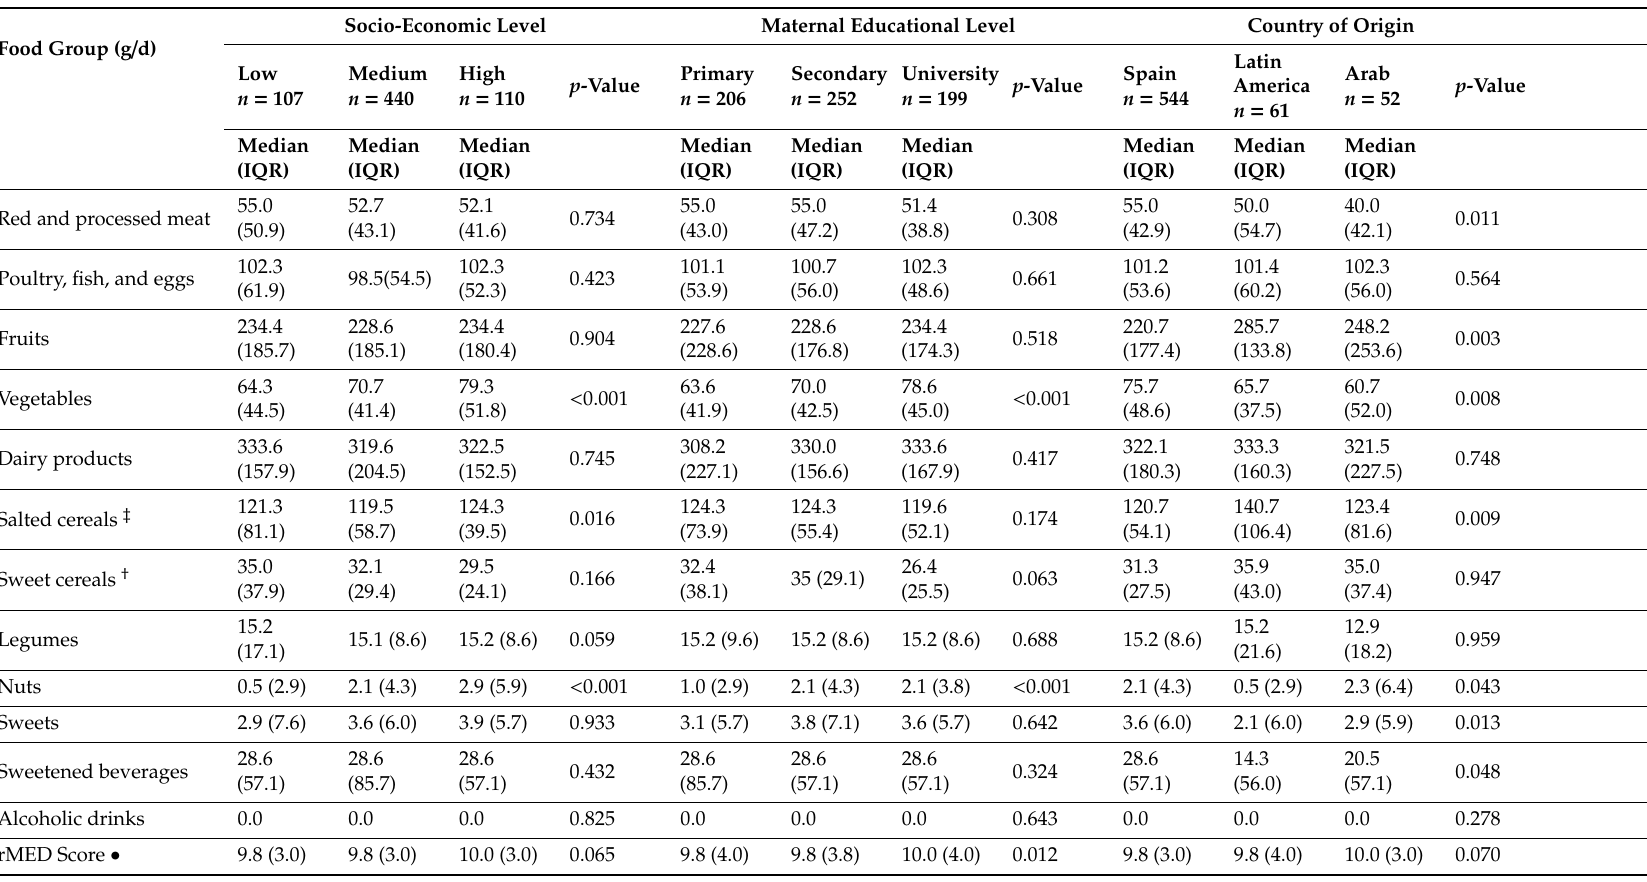
Table 4. Intake of food groups (g / d) and relative Mediterranean Diet Score during the first trimester of pregnancy according to maternal